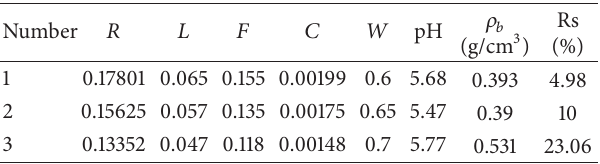
Table 4: Water effect content in xerogels shrinkage and bulk density (mass